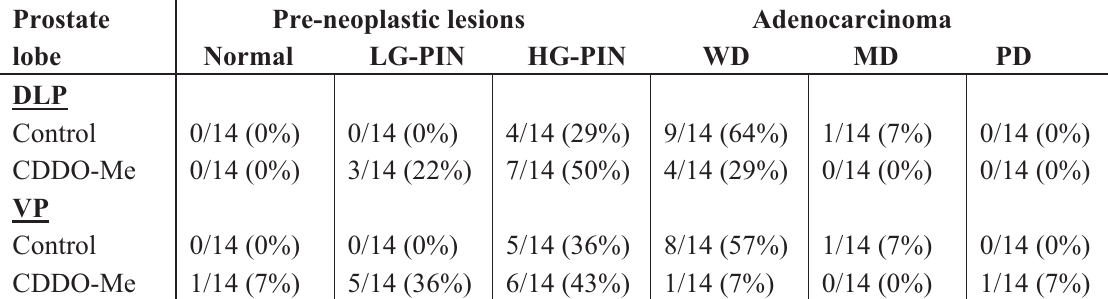
of pathologic lesions in the prostatic lobes.